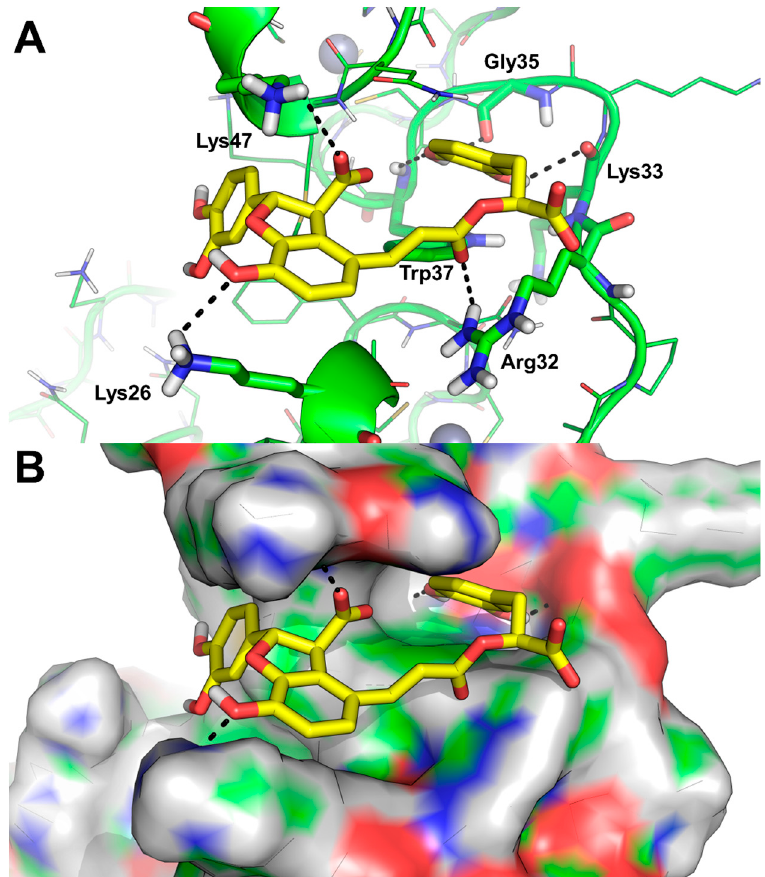
Figure 2. Predicted binding mode of lithospermic acid ( 1 ) to the NC hydrophobic pocket. ( A ) stick and line representation of the binding mode. The compound is shown as yellow sticks; protein residues are as green line, while the residues H-bonded to the compound are shown as sticks and are labeled; Zn(II) ions are shown as grey spheres. Polar contacts are highlighted by yellow dashed lines. ( B ) Surface representation of the NC binding groove.